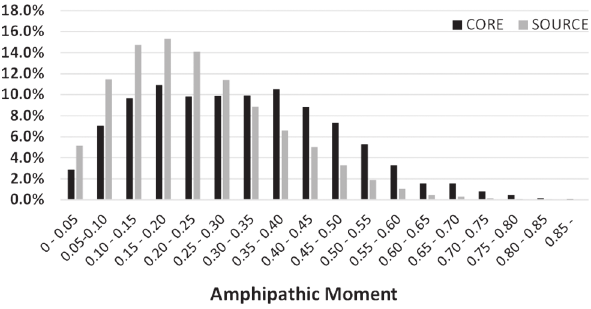
Fig 6. Statistical distribution of the amphipathicity of AMP critical regions and the